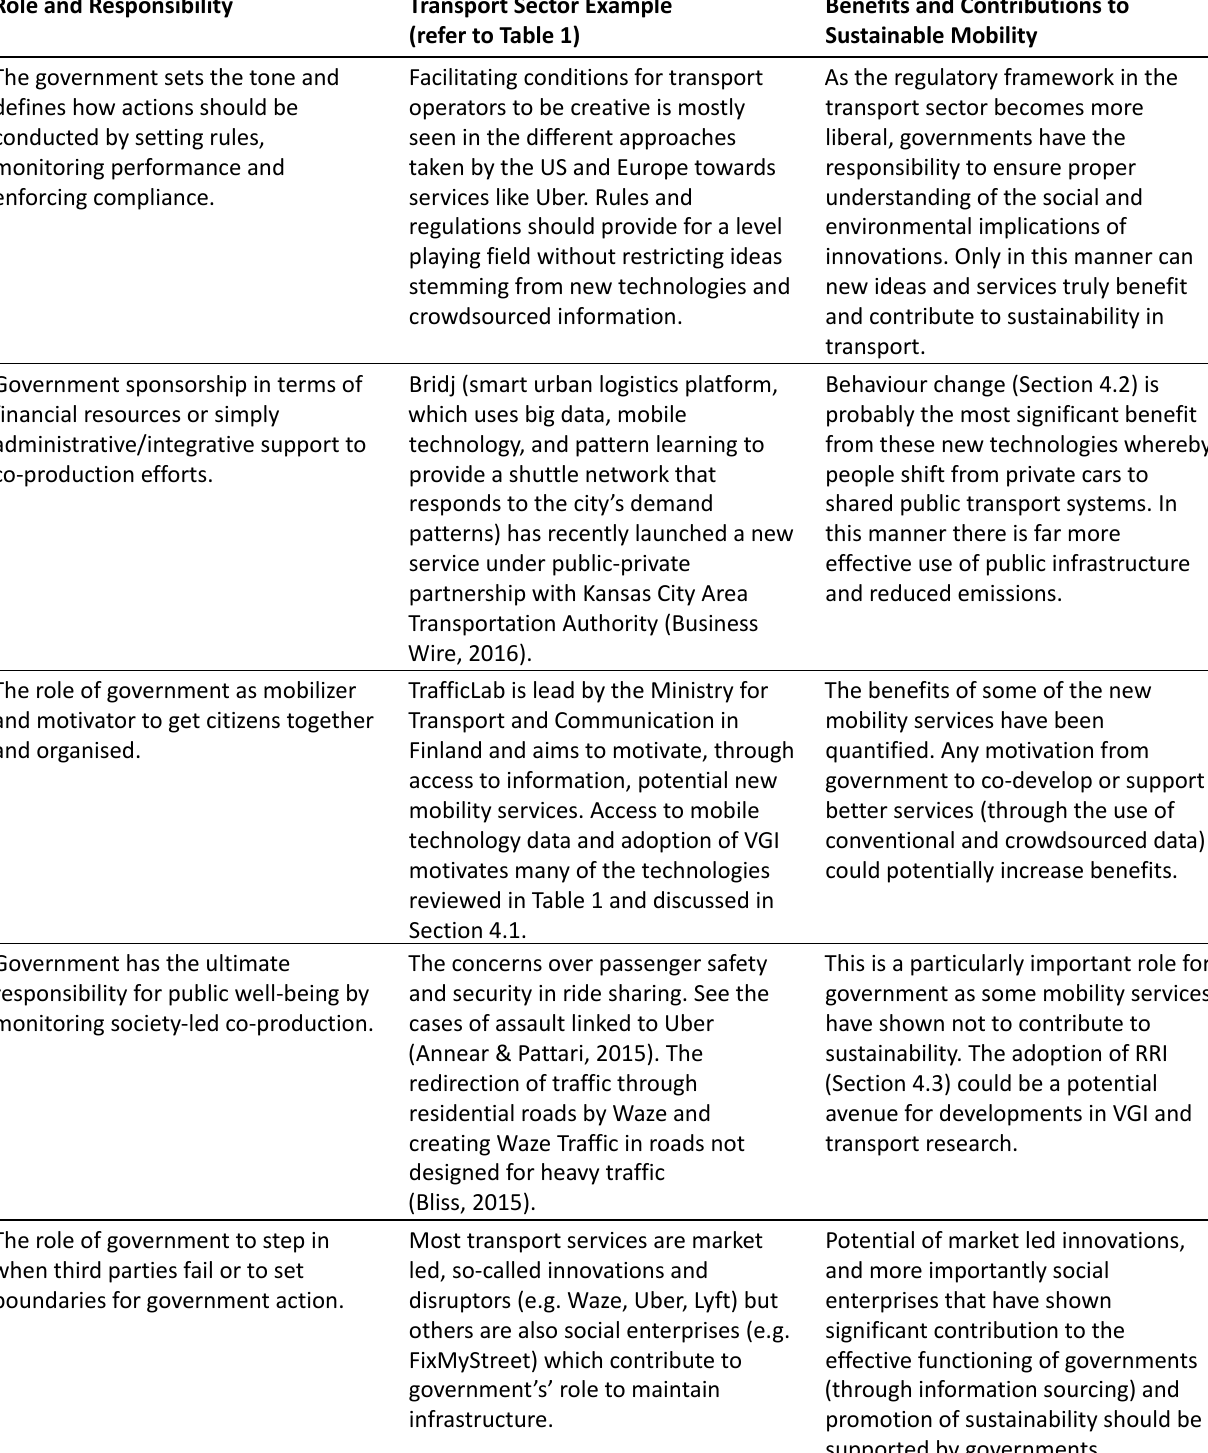
Table 2. Government roles and responsibilities and transport sector